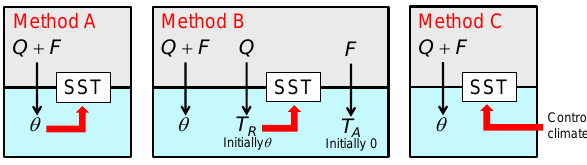
Figure 3. The three methods for treating the surface heat flux in faf- heat and faf-all, described in Sect. 2.4. The methods differ regarding the SST which is used to calculate the net surface heat flux Q from the atmosphere and sea ice into the ocean water. In method A it is obtained from the top-layer ocean temperature θ as usual in an AOGCM, in method B from the redistributed heat tracer T R , and in method C the SST and sea ice are prescribed from the climatology of the AOGCM control